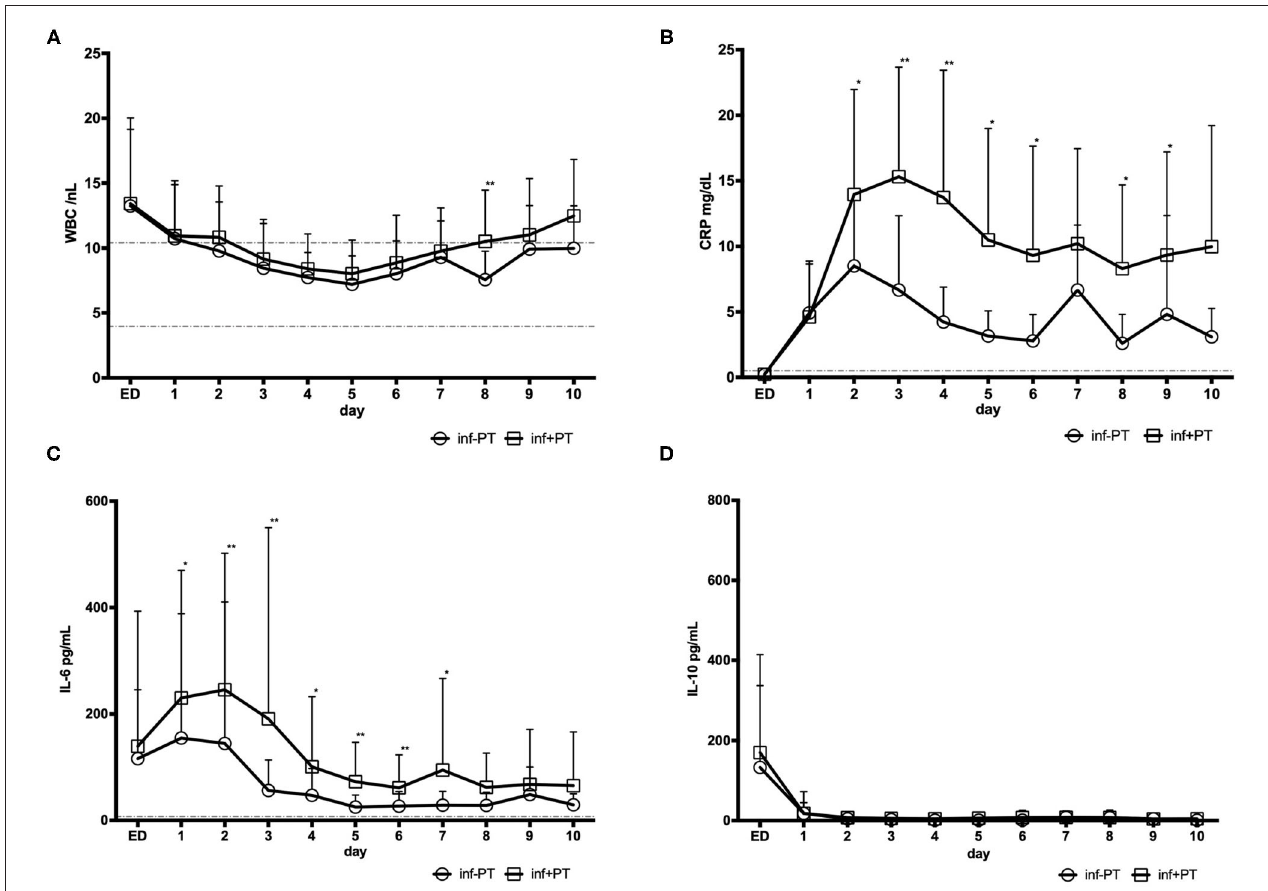
FIGURE 1 | Inflammation markers in trauma patients with (inf + PT) and without (inf-PT) post-traumatic infection (A) Leukocytes with reference range 3.96–10.41/ nL (B) CRP (C-Reactive Protein) in mg/dL with reference range < 0.5 mg/dL (C) Interleukine(IL-)6 with reference range < 7 pg/mL and (D) Interleukine(IL-)10 (no reference range).